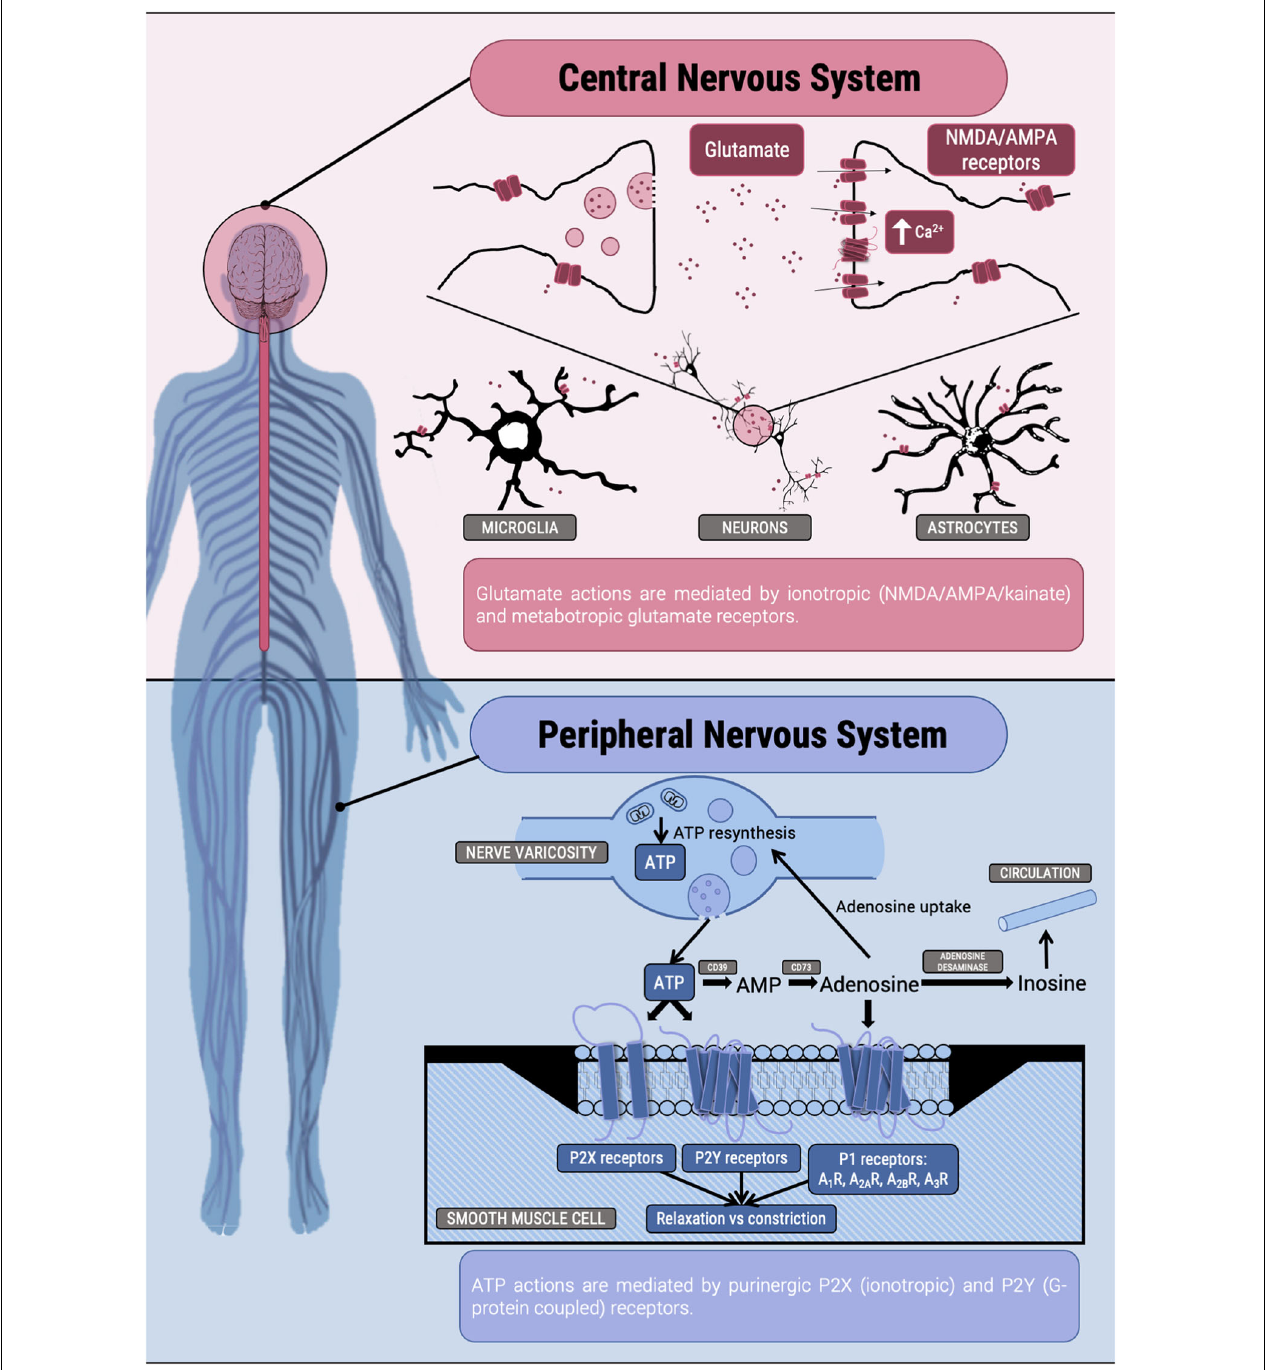
FIGURE 1 | Scheme of some actions of Glu and ATP in the nervous